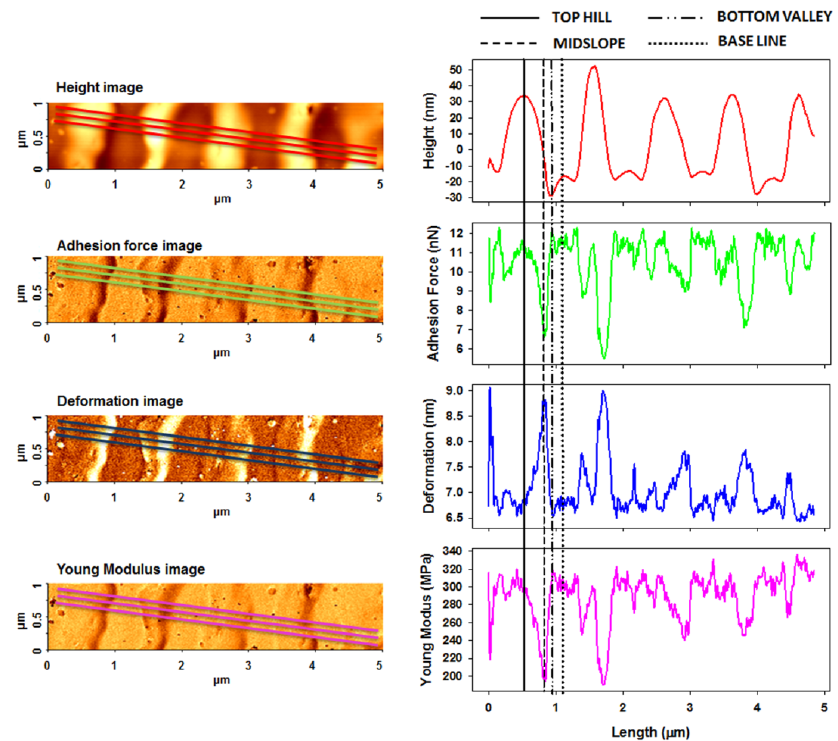
Figure 7. AFM PinPoint combined height, adhesion force, deformation, and Young’s modulus AFM images and corresponding cross-section profiles mediated from the presented three lines obtained for azo-polyimide irradiated with a laser energy density of 45 mJ/cm 2 and 10 pulses. As seen in Table 2, the pristine AzoPI presented an average adhesion force of 12.6 ± 0.8 nN, deformation of 5.1 ± 0.2 nm, and Young’s modulus of 294.8 ± 20.5 MPa. After the SRG formation as a result of pulsed UV laser irradiation, these nanomechanical charac- teristics were found to be different, depending on the region of the modulation where the measurements were made, namely, on SRG top hills, middle slope, bottom valleys, and baseline, as indicated in Figure 5. Thus, various values of nanomechanical parameters were obtained in these different regions, mostly induced by the density of the material, but not limited to it. As mentioned above, the valley of the SRGs corresponds to the highest intensity of the UV laser irradiation through the phase mask. In this region, the macromolecules containing azo groups in the lateral chains undergo photo-isomerization during irradia- tion, when transitions from stable trans state to metastable cis state occurs along with changes in the molecular length and the dipole moment (Figure 9) [65]. This phenome- non will engender a localized substantial nanoscale stress, requiring more free volume for the local motion of azo groups from the lateral chain in cis configuration [52] and movement of the whole azo-polyimide backbone, inducing a dilatation effect and a con- tinuous disturbance of the localized stress field [66].